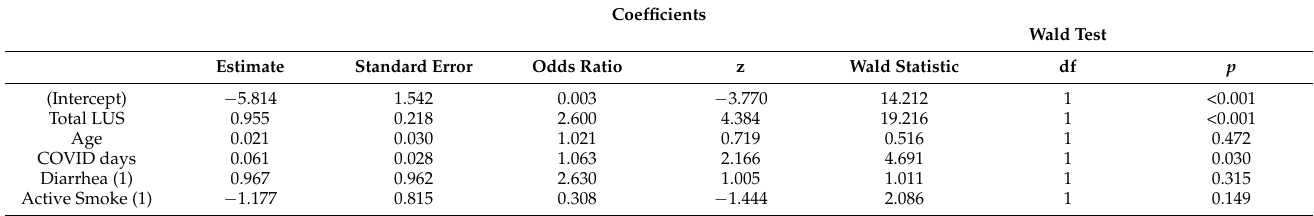
Table 5. Logistic regression coefficients of predictors of COVID-19